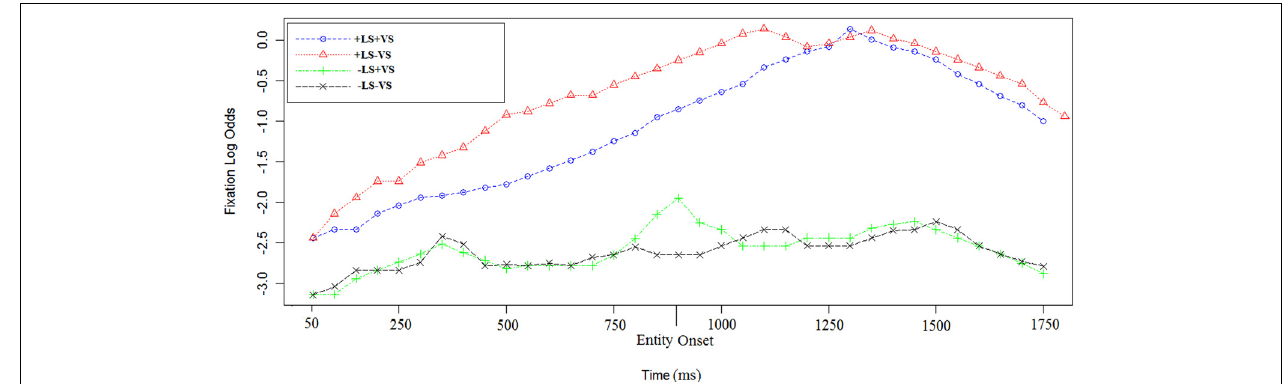
FIGURE 4 | Log odds of fixations during sentence c. in the four experimental conditions. The first time point corresponds to 50ms after the sentence target onset [e.g., “vineyard” in sentence (2)].